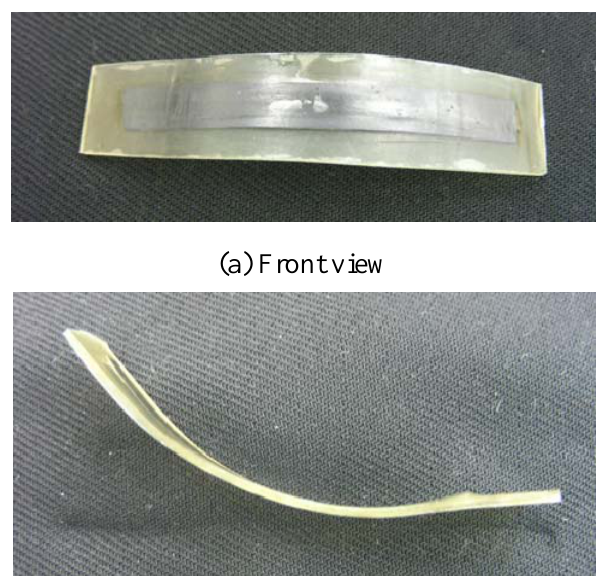
Figure 5. Photographs of the fabricated SMC